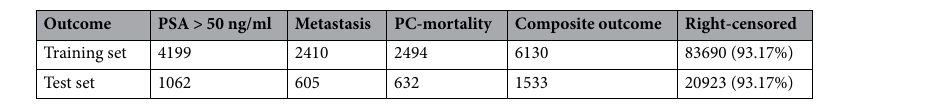
Table 2. Event statistics of different outcomes in the training and test sets.